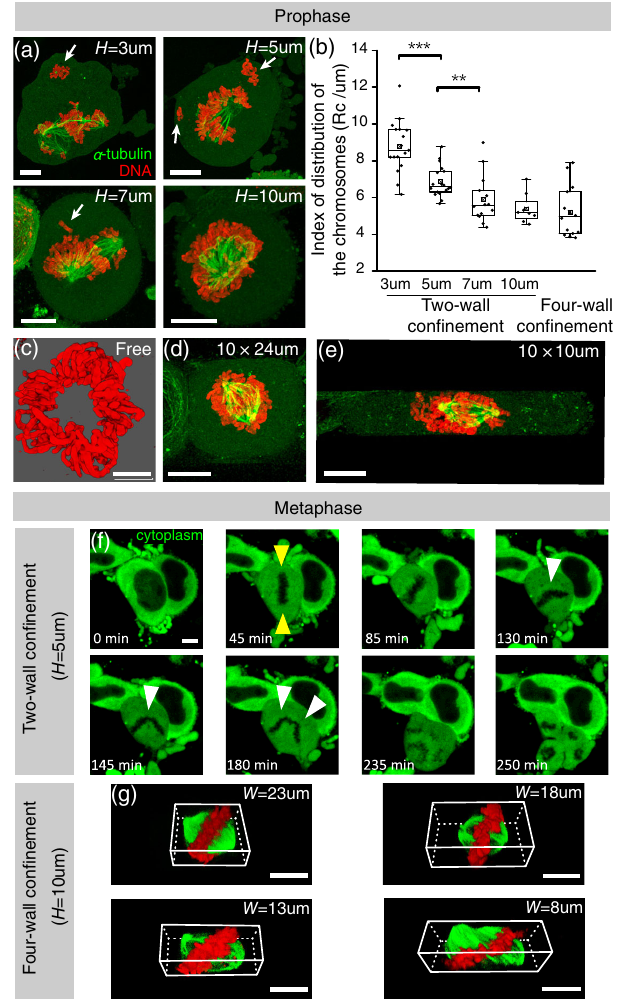
FIG. 3. Increase of pole splitting under two-wall confinement associated with chromosome scattering during the prometaphase and chromosome crowding during the metaphase. (a) Images of scattered chromosome distribution (arrows) during the early prometaphase under two-wall confinement with stained α tubulin (green) and DNA (red). The scale bar is 10 μ m. (b) Quantification of the degree of chromosome misalignment under two-wall confinement ( n ¼ 17 , 18, 14, and 8) and four-wall confinement ( n ¼ 24 ). We use the Mann-Whitney test with (cid:2)(cid:2) p < 0 . 01 and (cid:2)(cid:2)(cid:2) p < 0 . 001 . (c) Three-dimensional reconstruction image of toroidal chromosome distribution under no confinement. The scale bar is 5 μ m. (d,e) Images of chromosome distribution under four-wall confinement. The scale bar is 10 μ m. (f) Time-lapse images of chromosome arrangement under 5 - μ m height confine- ment. The short and thick chromosome plate (yellow arrowhead) bends into a long and thin chromosome plate by pole splitting (white arrowhead), due to the loss of appropriate accommodation for the bipolar chromosome plate. The scale bar is 10 μ m. (g) Three-dimensional reconstruction images of the chromosome metaphase plate under four-wall confinement. Appropriate four- wall confinement can provide adequate space to accommodate all chromosomes by tilting the metaphase plate during the meta- phase. The scale bar is 10 μ